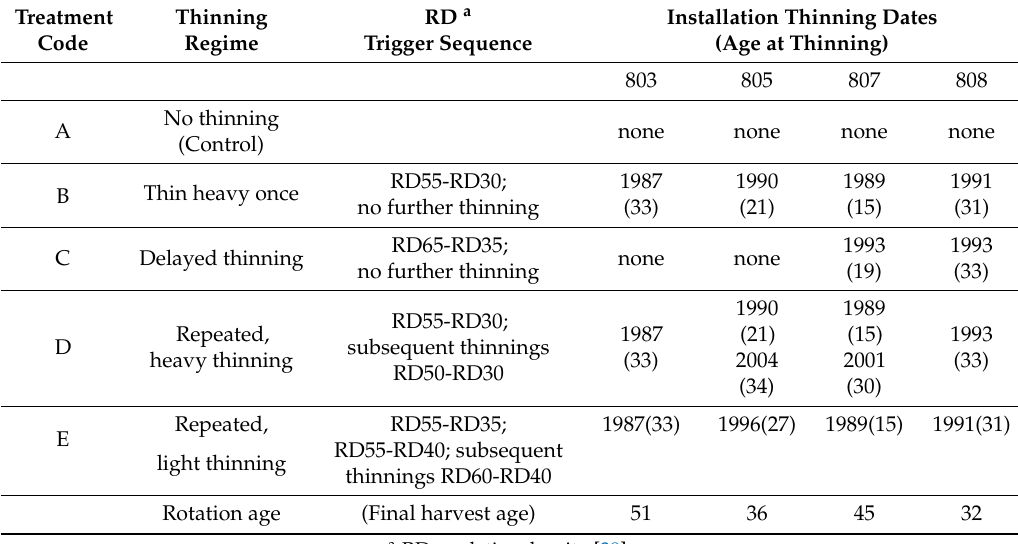
Figure 1. Locations of the Stand Management Cooperative (SMC) installations selected for this study. The numbers in red are the rotation ages of the stands when harvested. Table 1. Thinning regime, Relative Density triggers, and thinning dates (with corresponding stand ages) with the last row containing the rotation ages (final harvest ages in years since planting) for each installation. Study trees came from the final harvest.